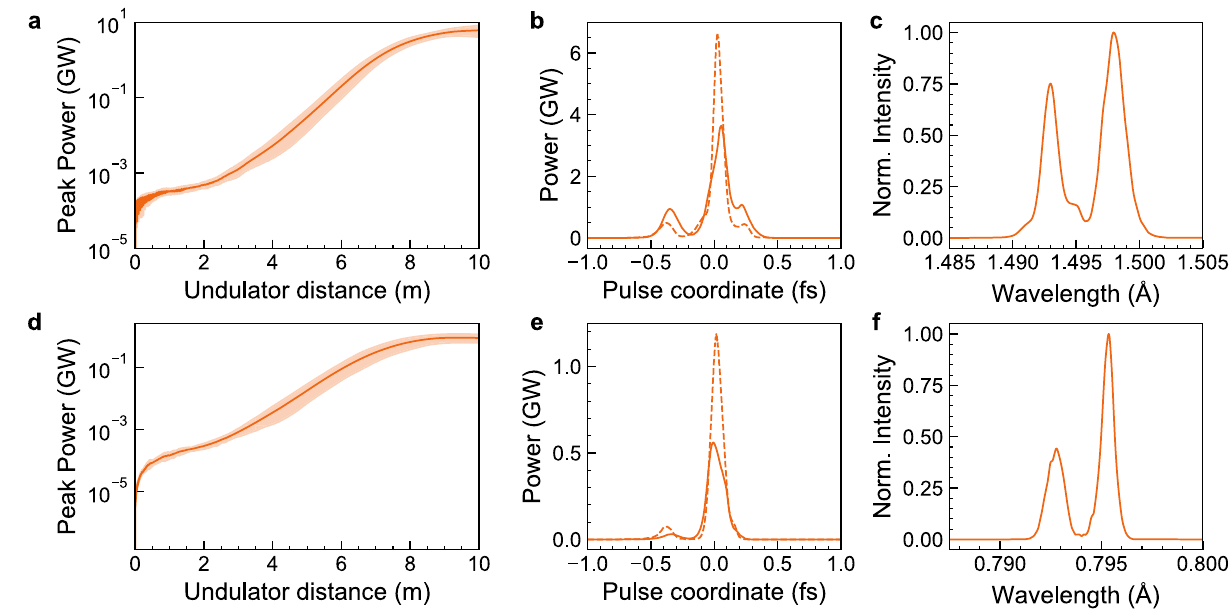
Fig. 4 | X-ray FEL pulse generation simulated with Puf fi n. Panels a – c an d d – f show power gain over the undulator distance, duration, and spectrum of the producedcoherenthardX-rayphotonpulsesforanundulatorwith λ u =5mm( a – c ) and λ u =3mm ( d – f ), respectively. The shaded plot gives the power gain variation for 10 simulated shots with different initial shot noises, and the dark orange solid